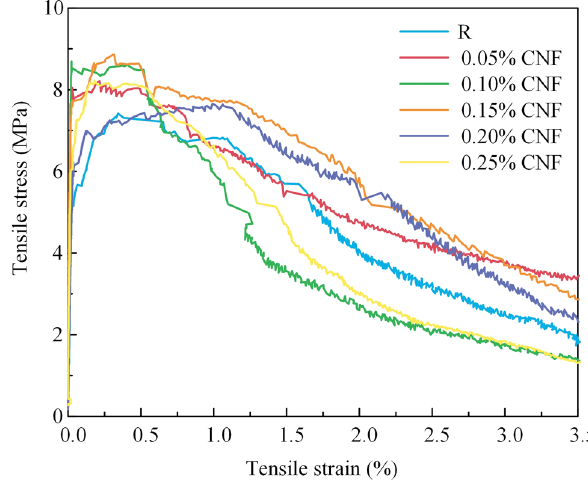
Figure 6: Tensile stress – strain curves of UHPC